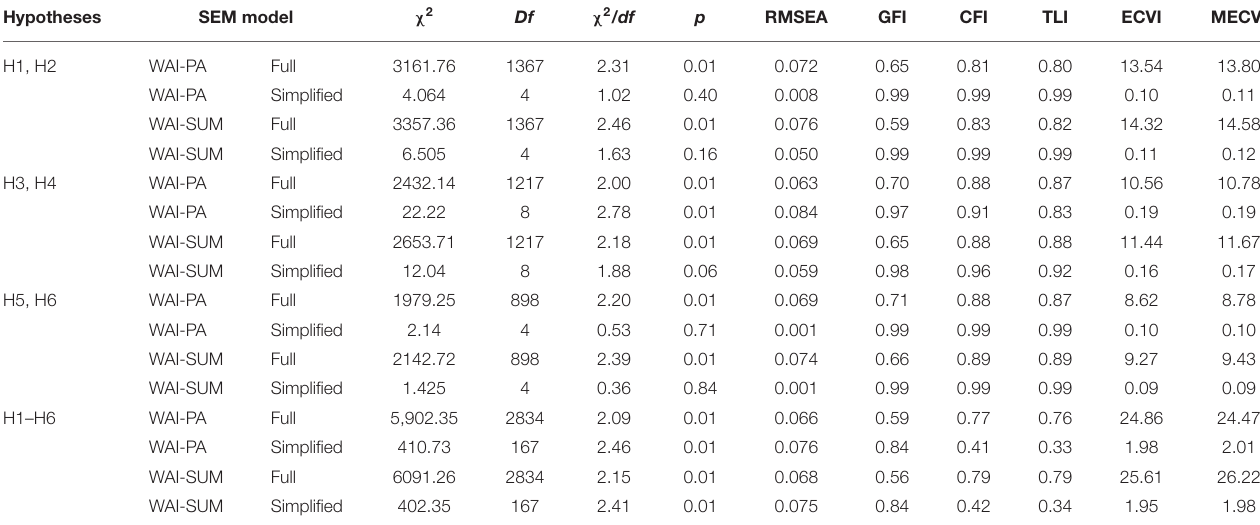
TABLE 1 | Fit indices of the tested models.